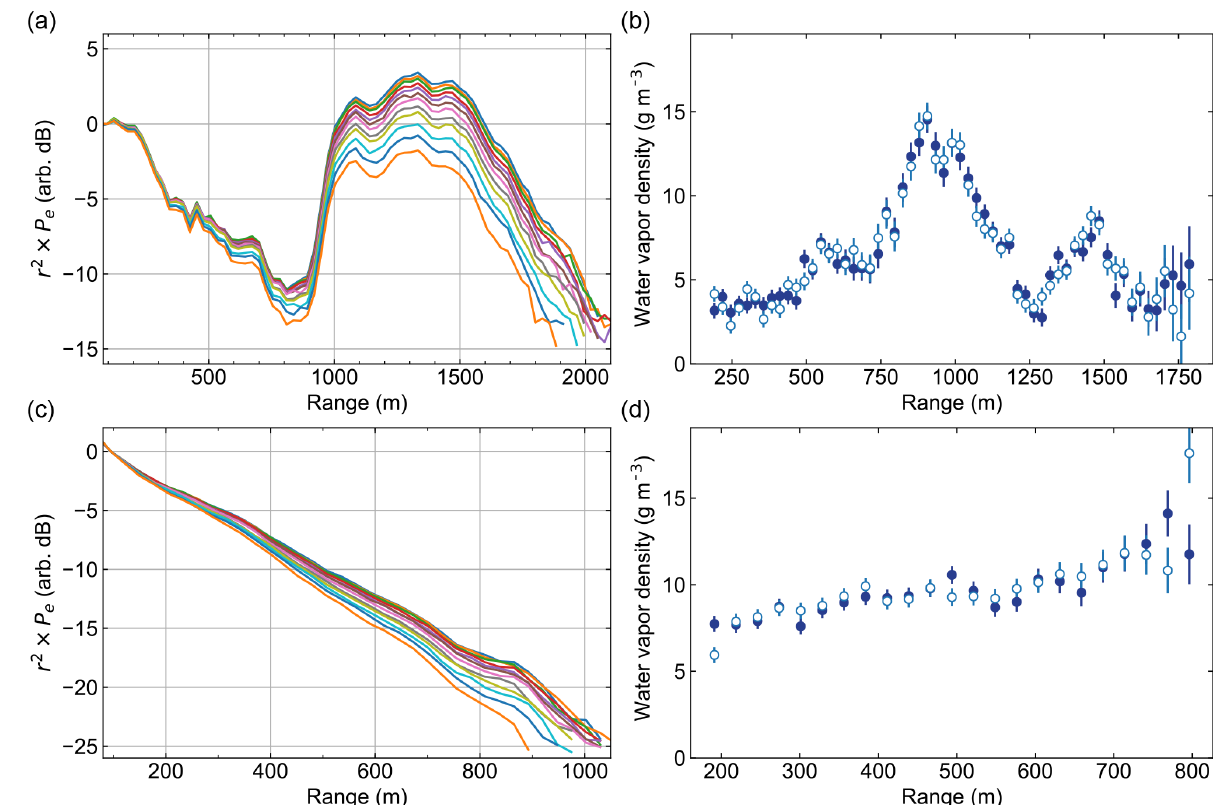
Figure 6. Retrievals for different cloud and precipitation conditions. (a) Averaged DAR power spectra ( N b = 11) for light rain near the surface, with a cloud extending from 1 to 2km. (b) Retrieved humidity profiles for two independent data sets corresponding to the same scene from (a) . (c) Averaged DAR power spectra ( N b = 11) for heavy precipitation near the surface with strong particulate extinction. (d) Independent retrievals from two data sets for the scene in (c)